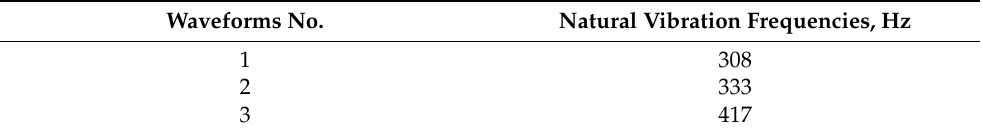
Table 3. FS natural frequencies and vibration modes. Waveforms No.